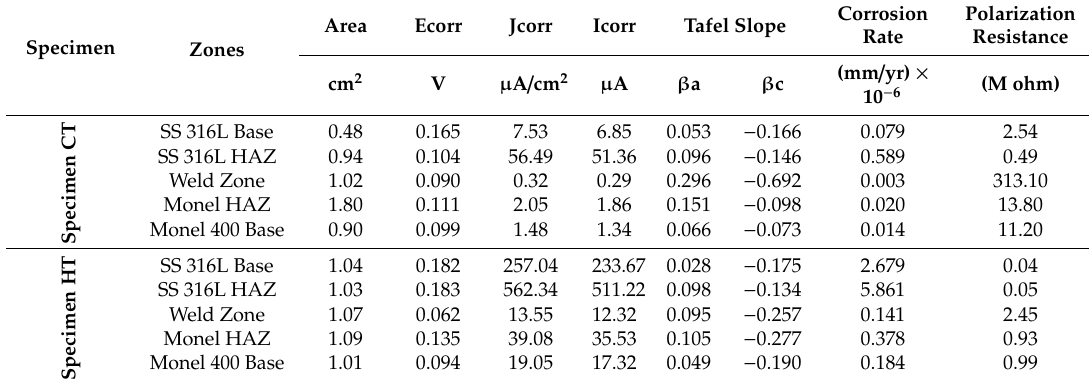
Table 3. Polarization parameters of Monel 400 and SS 316L for specimen’s CT and HT.